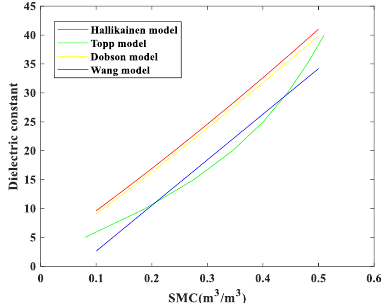
Figure 13 . The four soil models on Kachinsky silty clay （ C=0.55 ， S=0.45 ） .